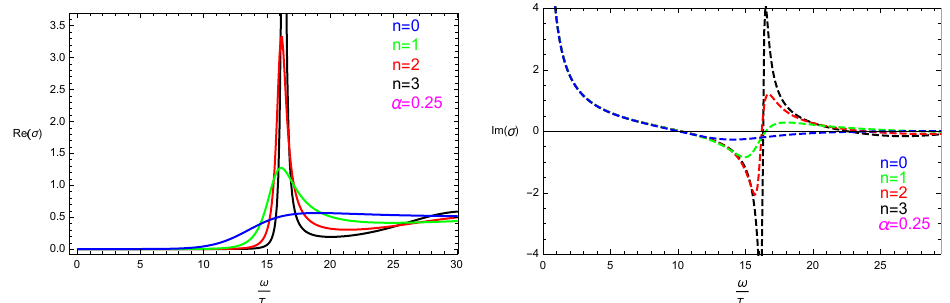
= 3/4 with different eff